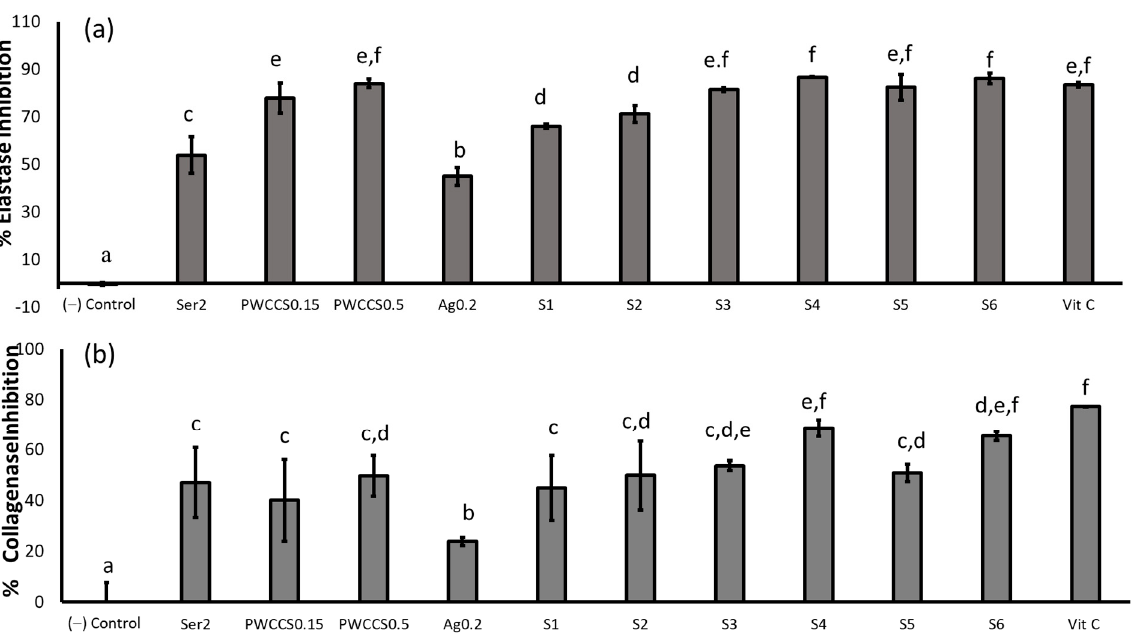
Figure 9. Elastase ( a ) and collagenase ( b ) inhibitory effects of the hydrogel formulations and their components in the B16F10 melanoma cells treated with 2%sericin (Ser2), 0.15%PWCCS (PWCCS0.15), 0.5% PWCCS (PWCCS0.5), 0.2% alginate (Ag0.2), the formulations S1–S6, or ascorbic acid 100 µ g/mL (Vit C). Data represent the mean ± SEM of the three replicates. Statistical significance was evaluated by Duncan’s post-hoc test; a–f letters indicate significant differences between the group at p < 0.05.